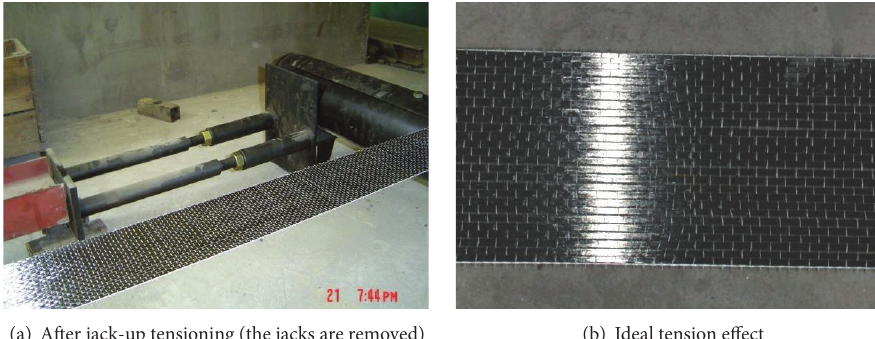
Figure 4: Ideal tension state of the CFRP